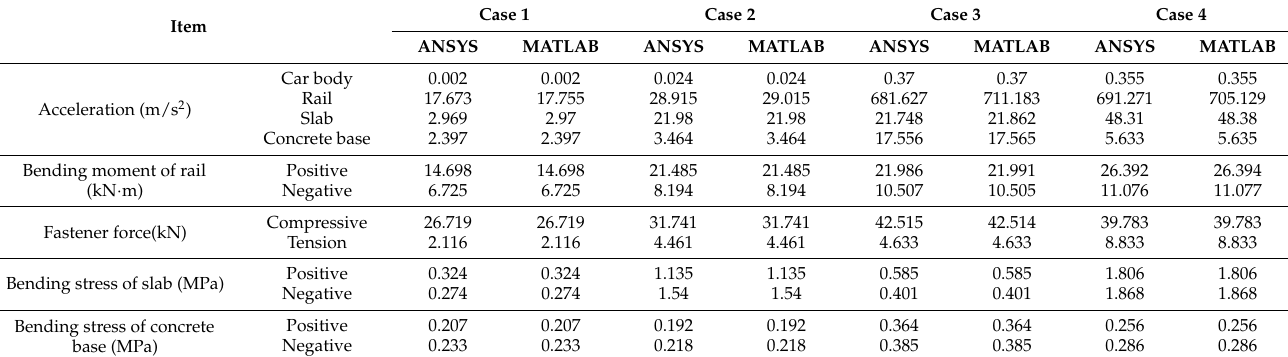
Table 3. Comparison of the largest dynamic responses of the coupled system calculated using ANSYS and MATLAB for different cases.